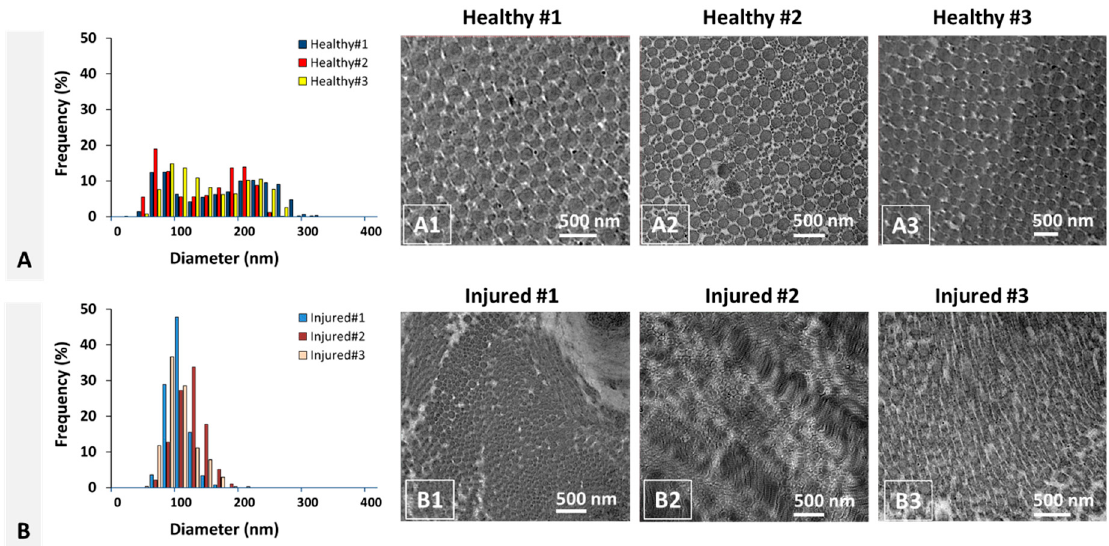
Figure 2. Diameter distribution of collagen fibrils from ( A ) healthy and ( B ) injured ACL tissue and respective ( A1 – A3,B1 – B3 ) transmission electron microscopy (TEM) images. ( A1 – A3 ) correspond to specimens obtained from ACL tissue of each healthy subject ( n = 3). ( B1 – B3 ) correspond to specimens obtained from ACL tissue of each injured subject ( n = 3).